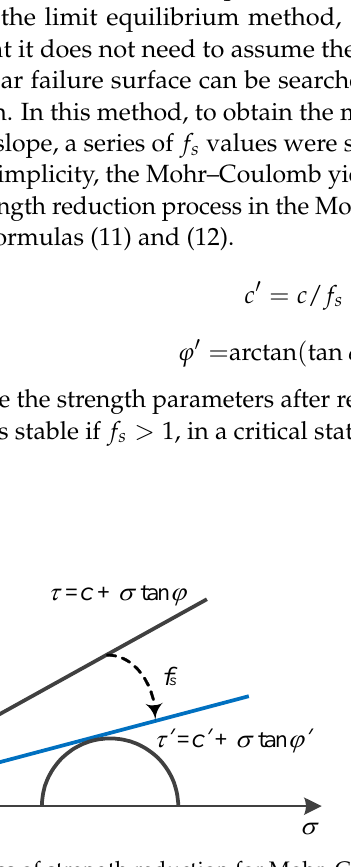
Figure 3. The process of strength reduction for Mohr – Coulomb constitutive.